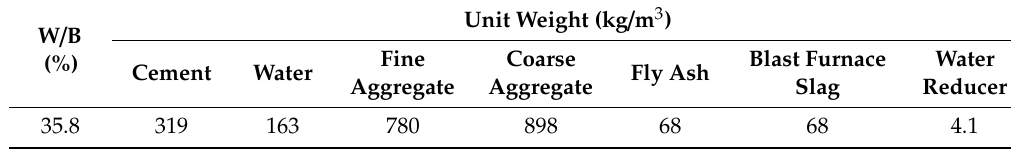
Table 2. Mix proportions of concrete.